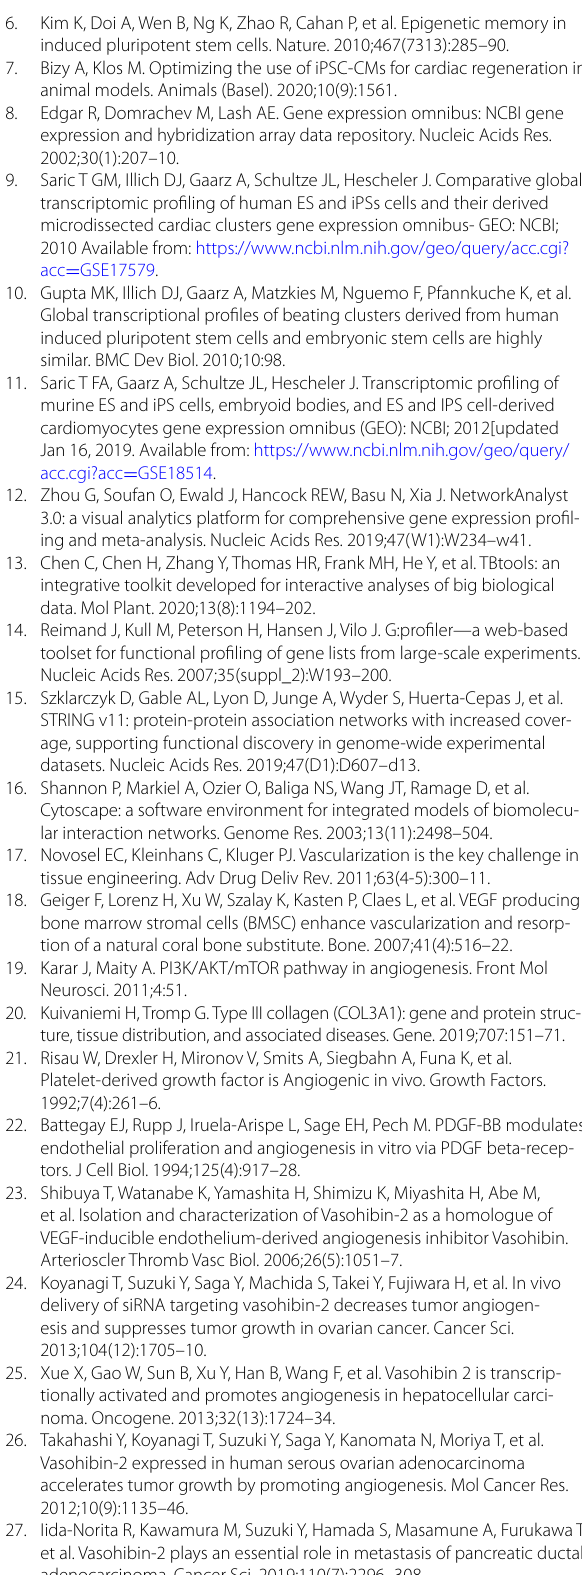
Additional file 2: Table S4. Top 5 Up- and down- regulated Genes for term from the human data set. Additional file 3: Table S5. Top 5 Up- and down- regulated Genes for each term from the mouse data set. Additional file 4: Table S6. Software and websites which were used in this